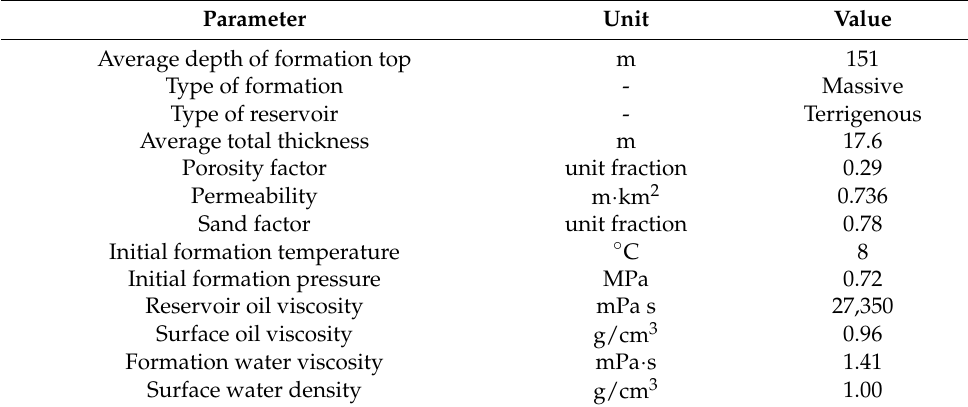
Table 2. General information about the Karabikulovskoye heavy oil field (U 2 layer).